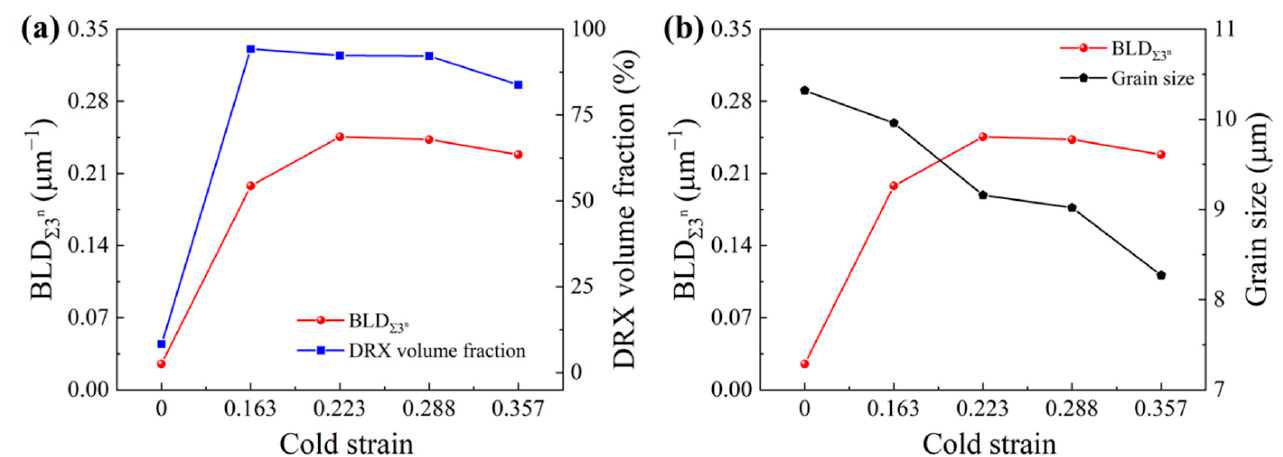
Figure 12. Relationships of BLD Σ 3n with DRX volume fraction ( a ) and grain size ( b ) varying with cold strain.